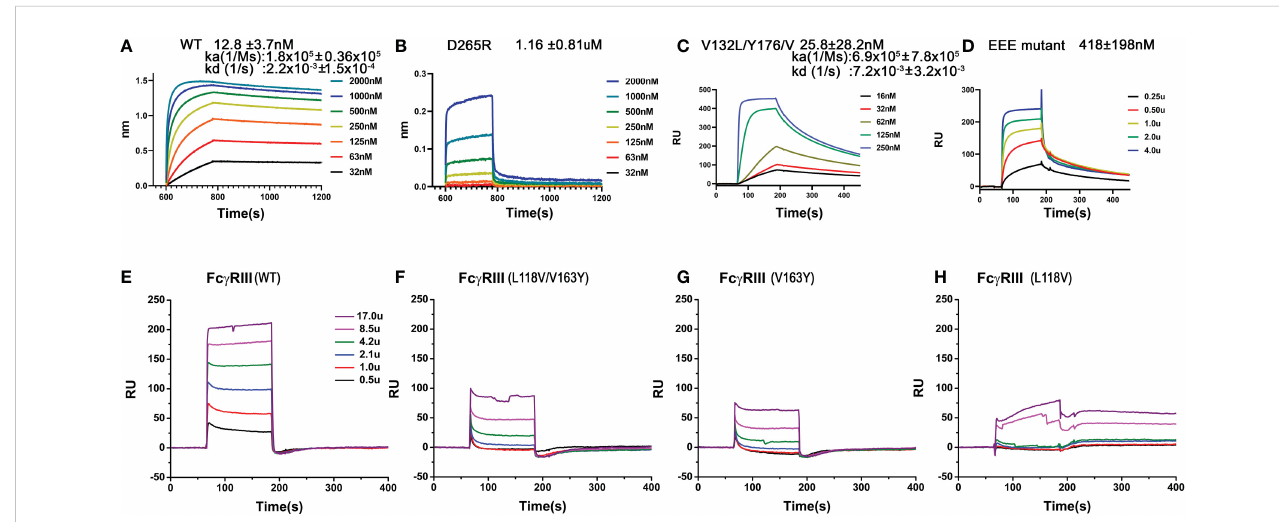
FIGURE 5 Binding of wildtype or mutant recombinant Fc g RI and Fc g RIII to IgG 1 . (A, B) Biolayer interferometry (BLI) measurements of Fc g RI binding to the wildtype and D265R mutant of VRC01. (C, D) SPR measurements of Fc g RI V132L/Y176V (C) and 173 KHR 175 to 173 EEE 175 (D) mutants binding to IgG 1 . (E – H) SPR measurements of Fc g RIII WT and mutants binding to IgG 1